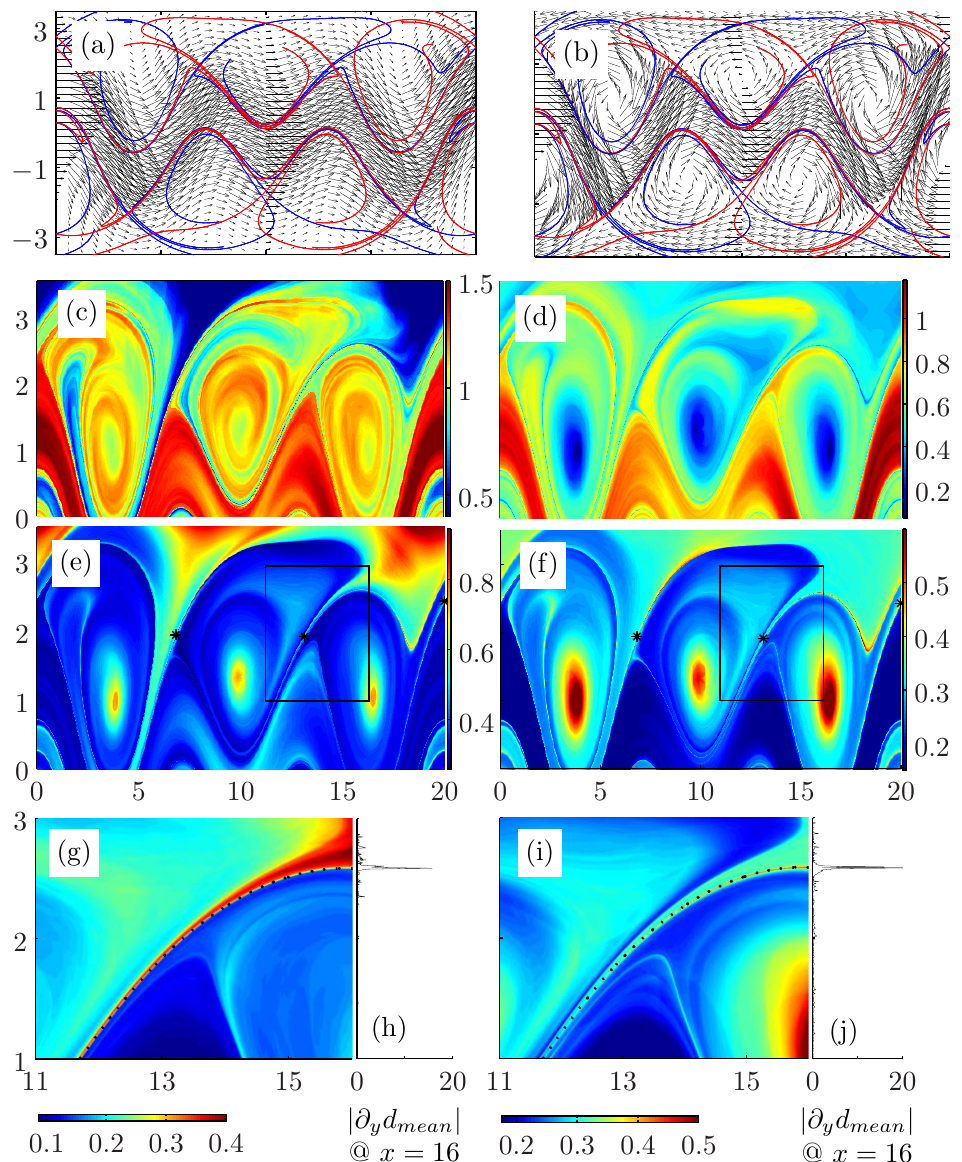
Fig. 3. Velocity and manifolds at t = 0 in stationary (a) and moving (b) reference frames; (c, d) c field computed forward in time with T int = 2 π/(k 2 (c 3 − c 2 )) ; (e, f) d mean field computed forward in time with T int = 2 π/(k 2 (c 3 − c 2 )) ; (g, i) magnified segment of the d mean field; (h, j) | ∂ y d mean | as a function of y at x = 16 for the Bickley jet flow in (left) stationary reference frame and (right) non-stationary reference frame moving with speed c 3 . The black dotted curve in (g, i) shows stable manifold computed using the direct evolution method. The black square in (e, f) indicates the portion of the plot that is magnified in (g, i) . Ticks on the x and y axes are given in Mm (1 Mm = 10 6